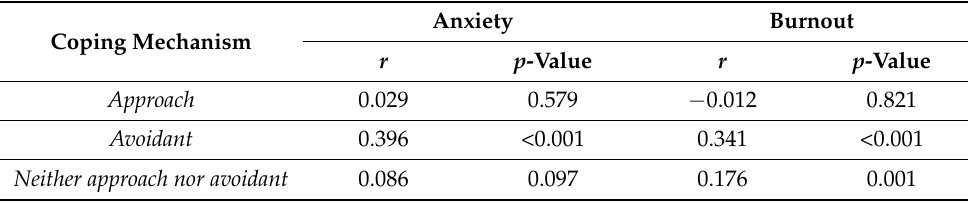
Table 5. Spearman’s correlation test for the associations of anxiety and burnout with the coping mechanisms